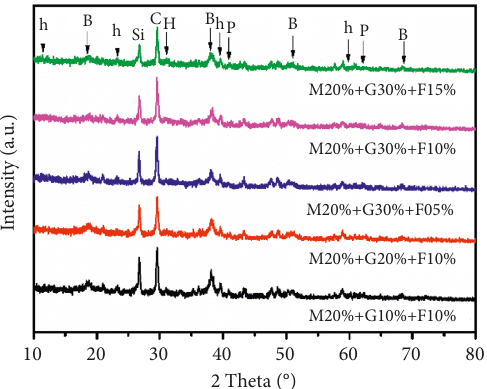
Figure 6: XRD pattern of bio-carbonated RMC-based WDC samples after 28 days of curing (h: hydrotalcite; H: hydromagnesite; B: brucite; P: MgO; C: CaCO 3 ; Si: SiO 2